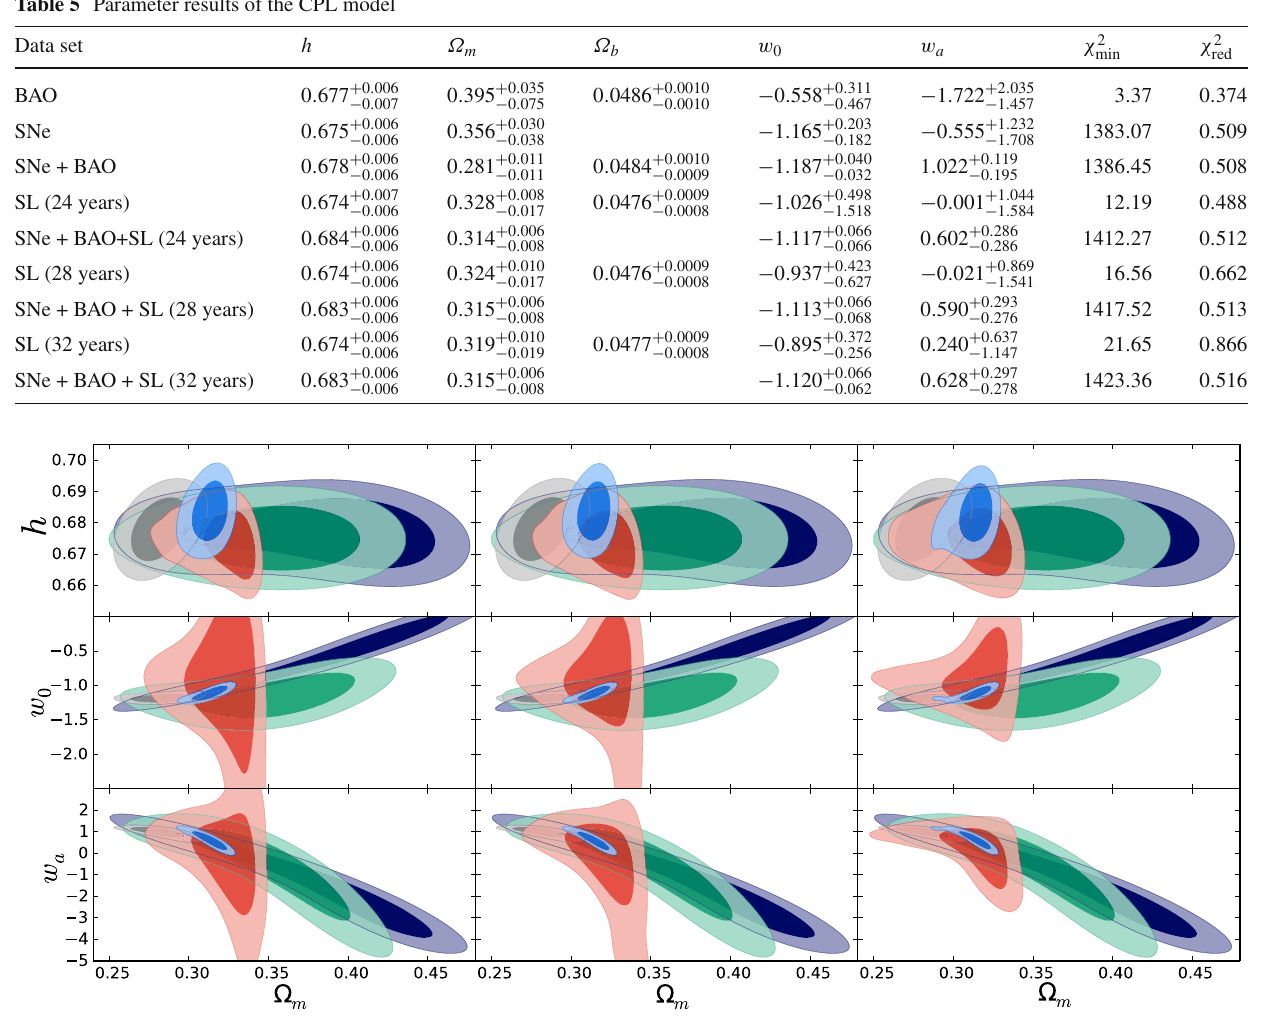
Fig. 7 CPL model; solid contours limit 1 σ regions and clear contours 2 σ region. Purple for the BAO, green for SNe and red for SL data set, gray for SNe + BAO and blue SL + BAO + SNe. First set (left) for 24 years, second (middle) for 28 and third (right) for 32